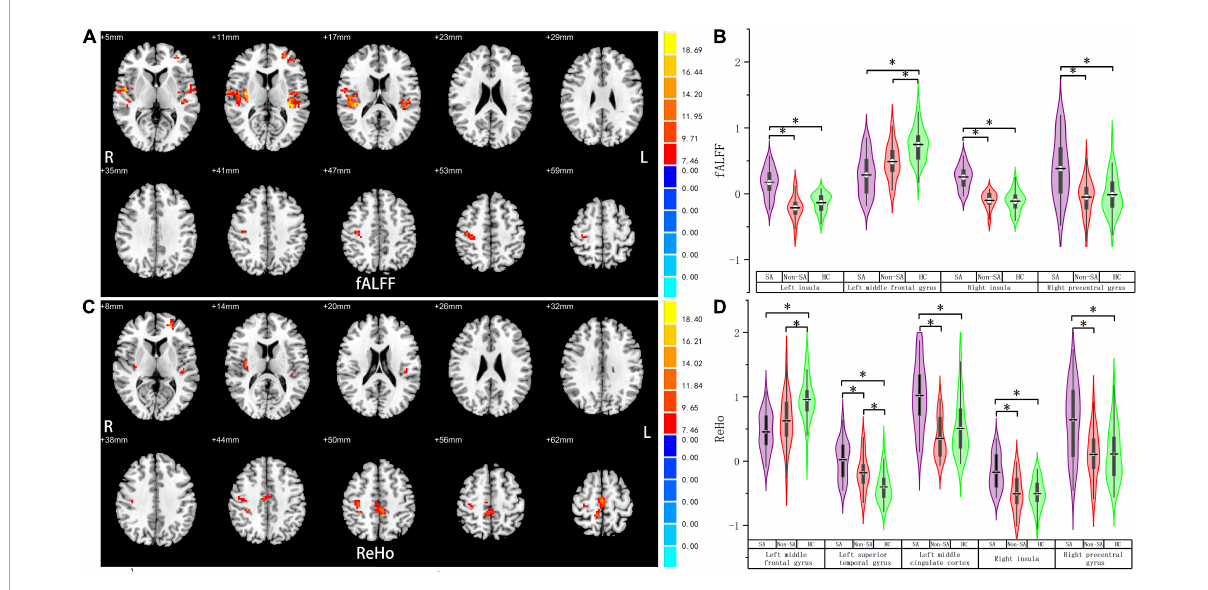
FIGURE1 Fractional amplitude of low-frequency fluctuation and regional homogeneity analysis. Brain regions where fALFF (A) and ReHo (C) values differed significantly among SA, non-SA, and HC groups, Monte Carlo simulation corrected. Post hoc two-sample t -tests revealed multiple alterations in the fALFF (B) and ReHo (D) between each pair of groups. “ ∗ ” indicates statistically